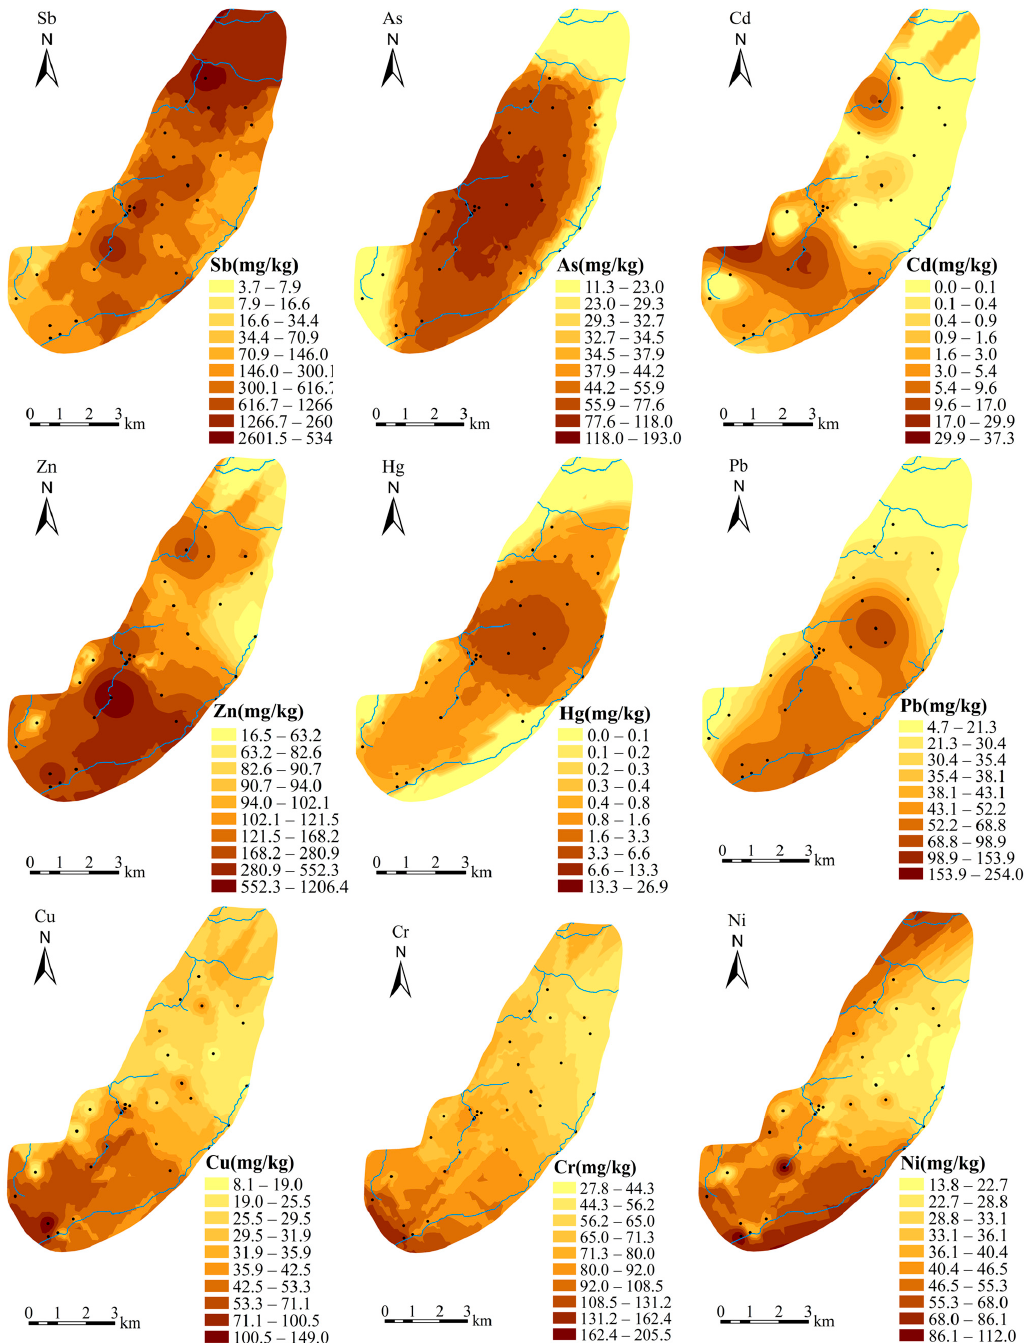
Figure 3. Distribution maps of heavy metals (Sb, As, Cd, Zn, Hg, Pb, Cr, Cu and Ni) in soil over the study area.